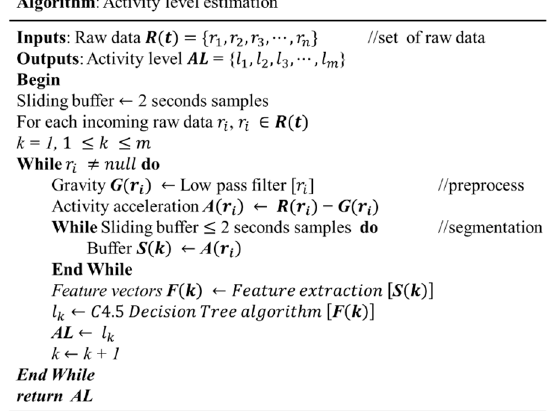
Figure 4. The activity level estimation procedure and algorithm.